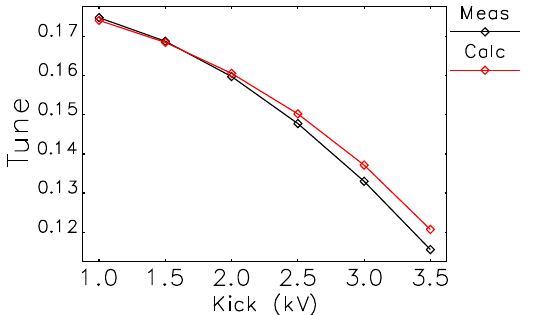
FIG. 5. Comparison of the kick aperture experiment and simulation for different bunch charge. The charge dependence agreement is